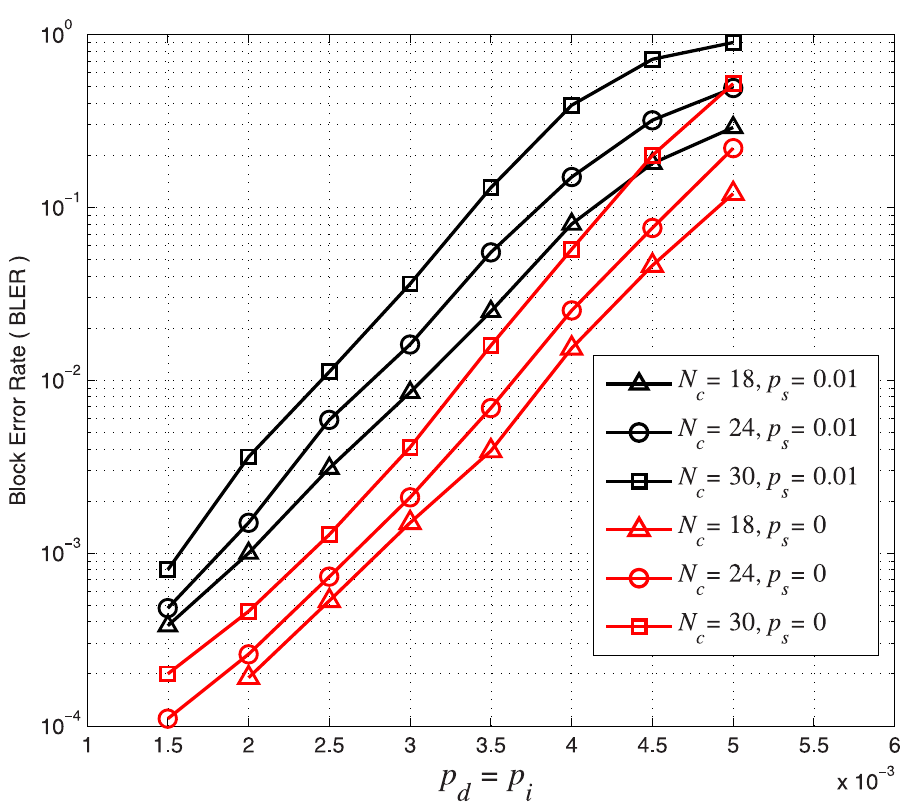
Fig 10. BLER of the concatenated LDPC-marker code over the CID channel. N m = 2 and N c = 18, 24, 30.